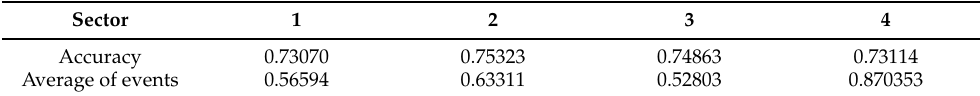
Table 3. Classification model results.